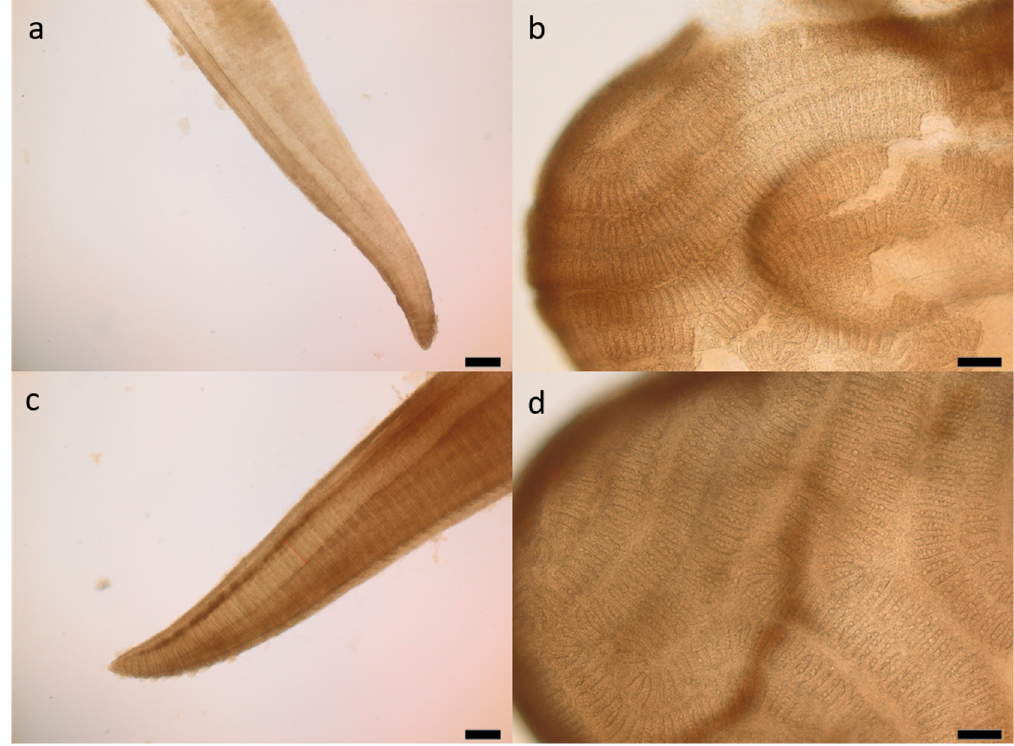
Figure 1. Gill filament of the P0 group ( a , b ) and the P120 group ( c , d ) without notable changes, scale bar 200 µm ( a , c ) and 100 µm ( b , d ).